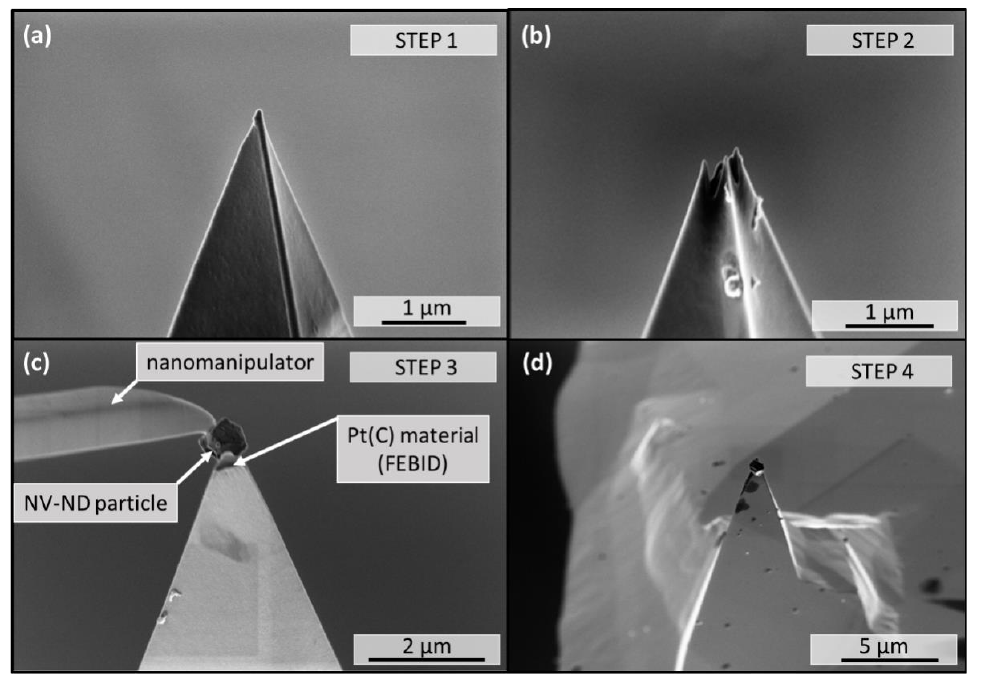
Figure 1. Development of cantilevers containing NV-rich nanodiamond (NV-ND) particles. ( a )